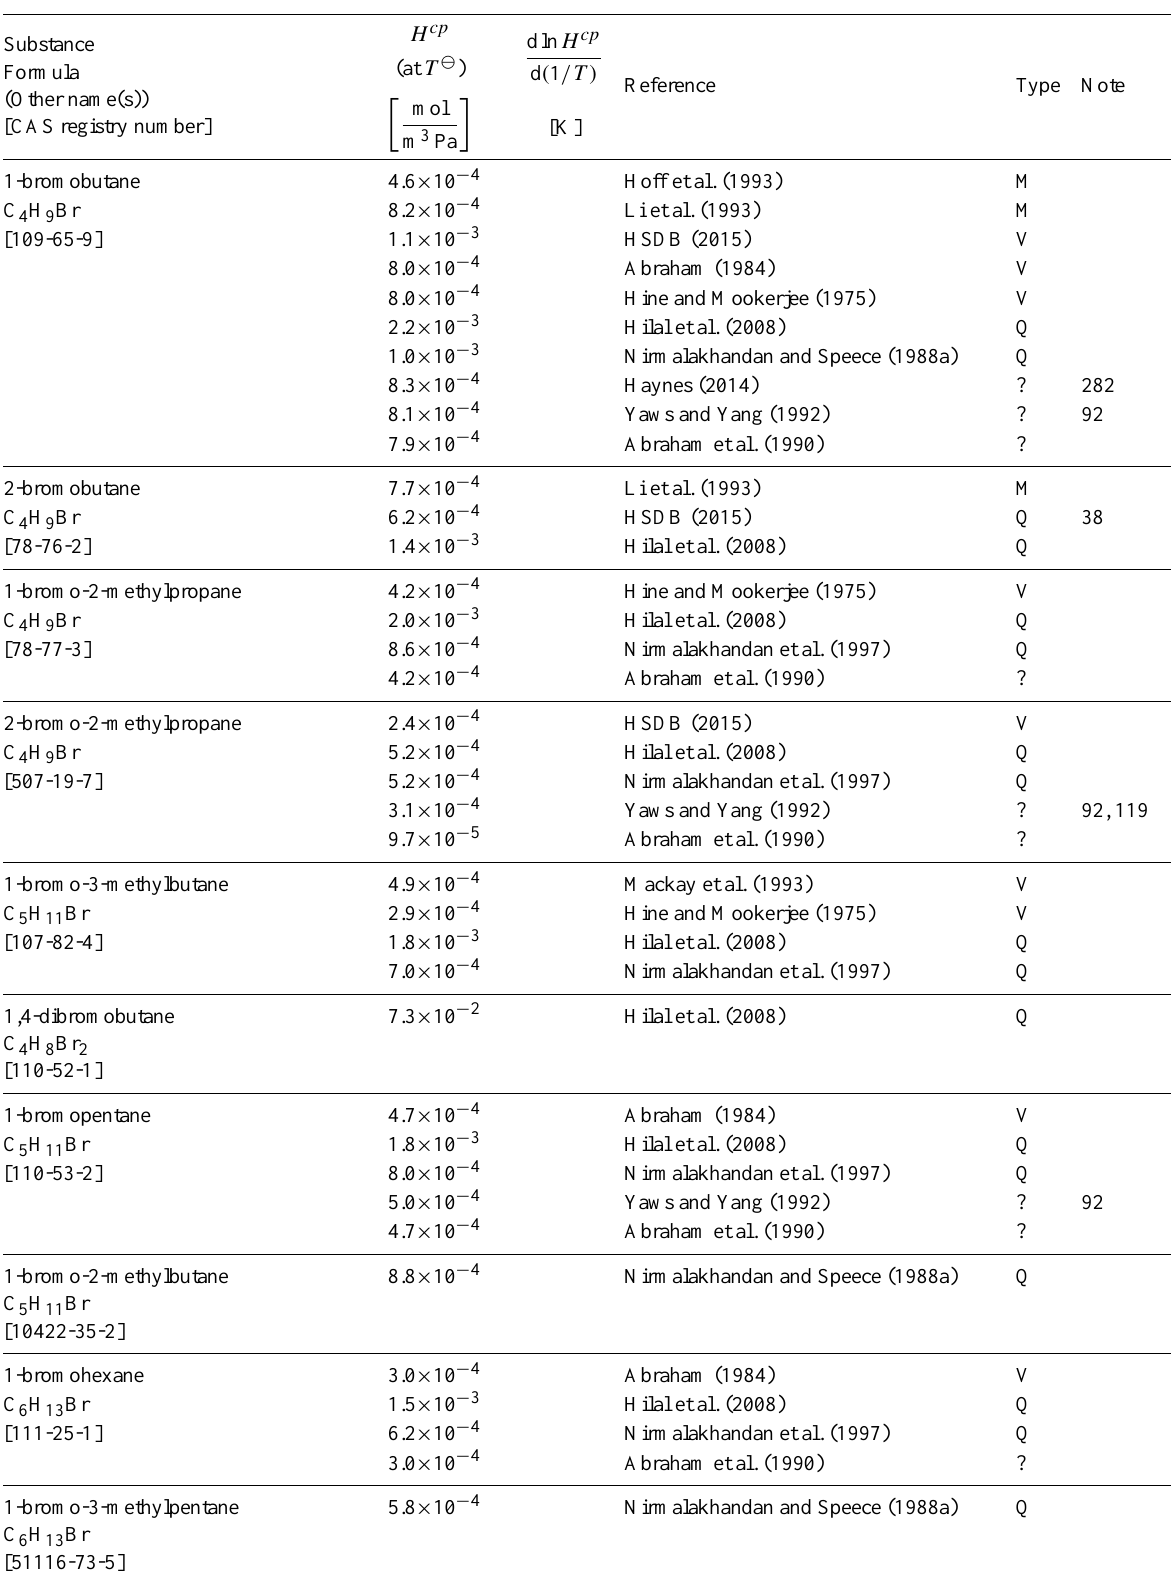
Table 6: Henry’s law constants for water as solvent